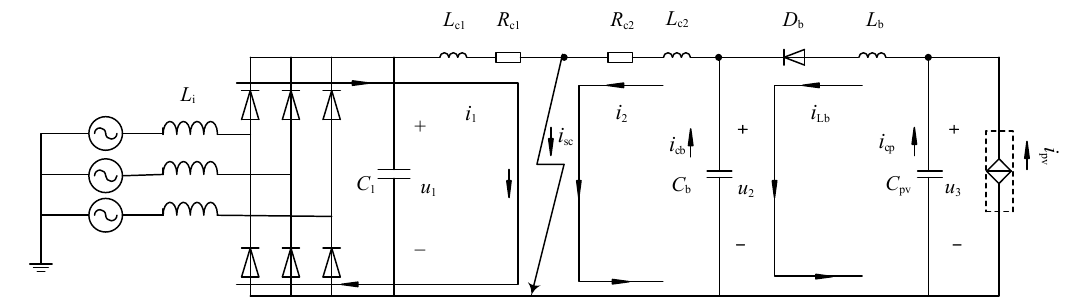
Figure 5. Equivalent circuits for the short-circuit fault at steady-state stage.